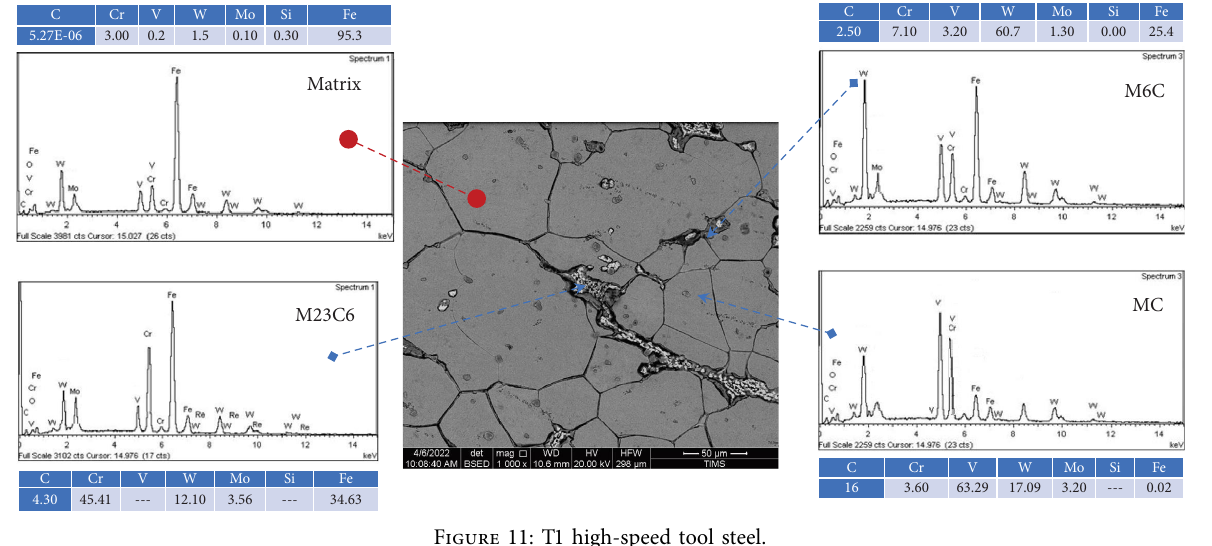
Figure 11: T1 high-speed tool steel.